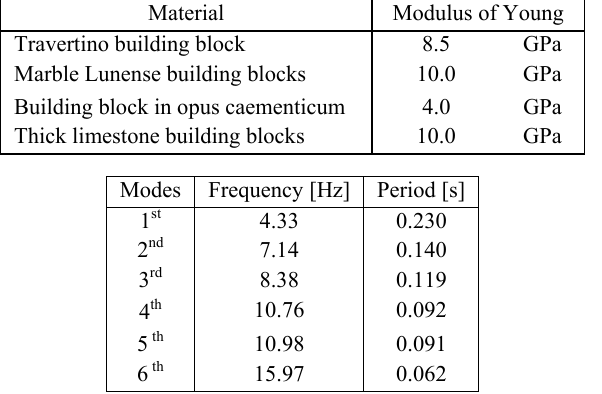
Figure 14. Comparison between numerical and signals data analyses Case